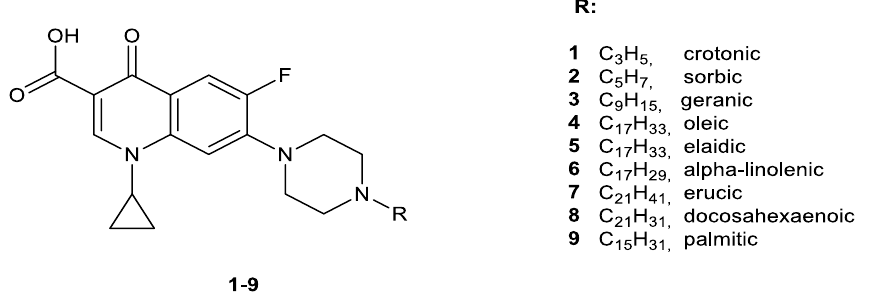
Table 1. Cytotoxic activity (IC 50 , µM) of studied compounds estimated by the MTT assay. Data are expressed as mean ± SD; a respective MXF conjugates; b IC 50 (µM) — the concentration of the com- pound that corresponds to a 50% growth inhibition of cell line as compared to the control after cultured the cells for 72 h with the individual compounds. c The SI (selectivity index) was calculated using formula: SI = IC 50 for normal cell line/IC 50 cancer cell line. d Human primary colon cancer (SW480); e human metastatic colon cancer (SW620); f human metastatic prostate cancer (PC3); g hu- man immortal keratinocyte cell line from adult human skin (HaCaT); h moxifloxacin; i ciprofloxacin; j,k reference compounds commonly used in cancer treatment. of the short-chain fatty acids ( 1m , 2m , and 14m ). The MIC values against staphylococci Normal Cancer Cells achieved by the compound 14m varied from 0.25 µ g/mL to 1 µ g/mL, whereas derivatives Cells 1m and 2m inhibited their growth at concentrations of 0.5–2 µ g/mL. Conjugates of poly- Compound a SW480 d SW620 e HaCaT g ( 8m ) and monounsaturated ( 10m ) acids were moderately active (MIC 2–4 µ g/mL), similarly Name of Fatty Chain Length: as the saturated amide 15m (MIC 4–8 µ g/mL). Other medium- ( 3m ) and long-chain ( 6m , 13m ) polyunsaturated compounds were effective in the range of 8–32 µ g/mL. Long-chain amides ( 4m , 5m , 7m , 9m , 11m , 12m , 16m ) formed a group of conjugates of the lowest antimicrobial activity (MIC > 32 µ g/mL). Gram-negative isolates were more resistant to the presence of the studied compounds. Only derivatives 8m , 14m , 1m , and 13m , applied at concentrations of 2–16 µ g/mL, inhibited the growth of E. coli strains. Within MXF amides, the derivative 14m was equally or even twice as active against selected S. aureus strains when compared to the reference CP. The compound 1m was as potent as the standard CP towards three Staphylococcal isolates. In contrast, none of the MXF analogues were as effective as the non-conjugated